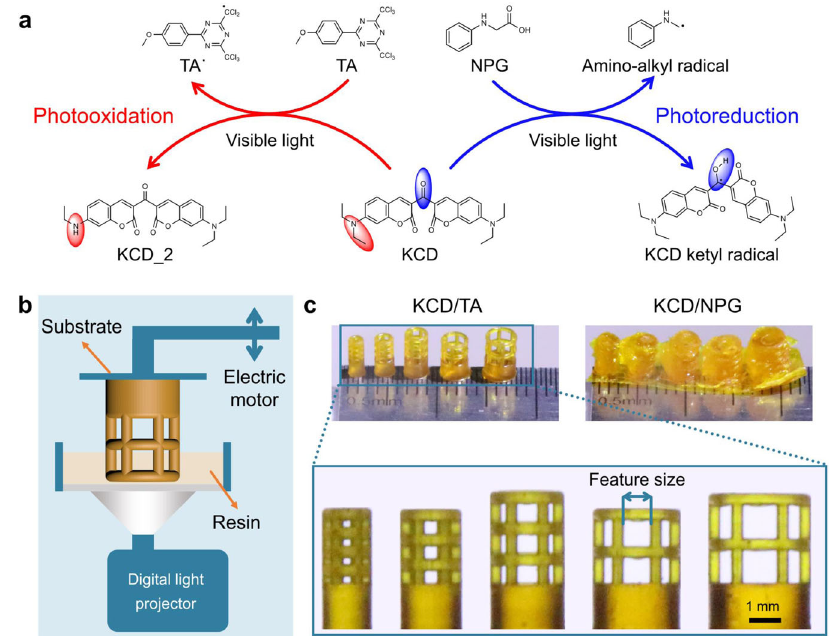
Fig. 2 Comparison of print fi delity between KCD/TA and KCD/NPG systems. a Schematic illustration of the photooxidation of KCD by TA and photoreduction by NPG upon visible light irradiation, respectively. b Schematic illustration of the bottom-up DLP 3D printing. c 3D-printed objects photomediated by KCD/TA and KCD/NPG, respectively, which were printed using the bottom-up DLP 3D printer (Titan 2, Kudo3D). The 3D-printed objects were cleaned with ethanol and then postcured under UV fl ood for 10 min. Color of the printed objects comes from KCD and KCD_2.